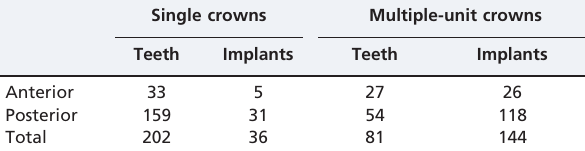
Table 1 - Distribution of the single- and multiple-unit zirconia crowns on teeth and on implants by region.